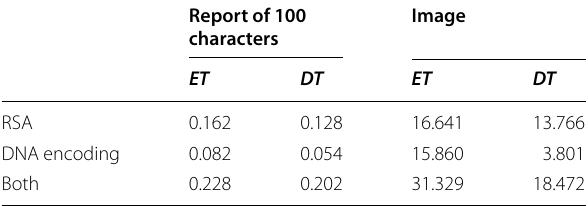
Table 3 Encryption/decryption time for each algorithm in sec